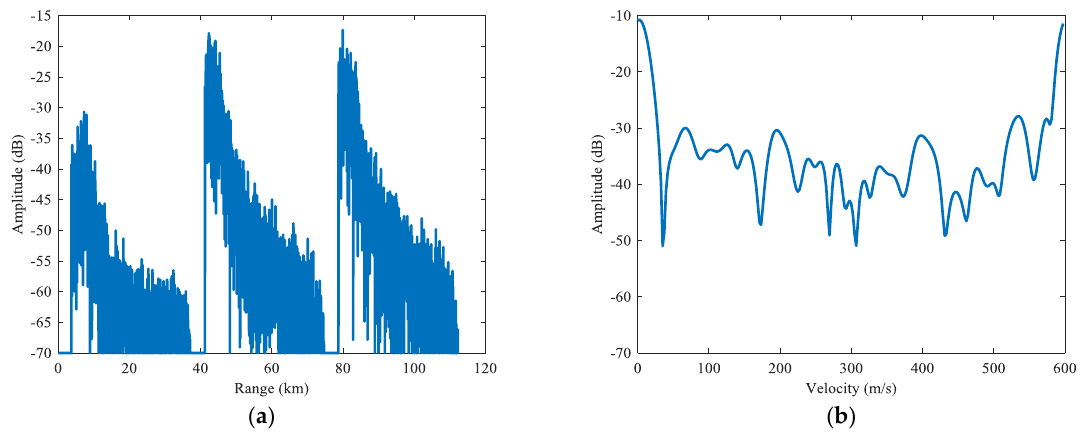
Figure 7. Cross profiles of Target 1 for traditional PD process: ( a ) range profile, ( b ) Doppler profile.